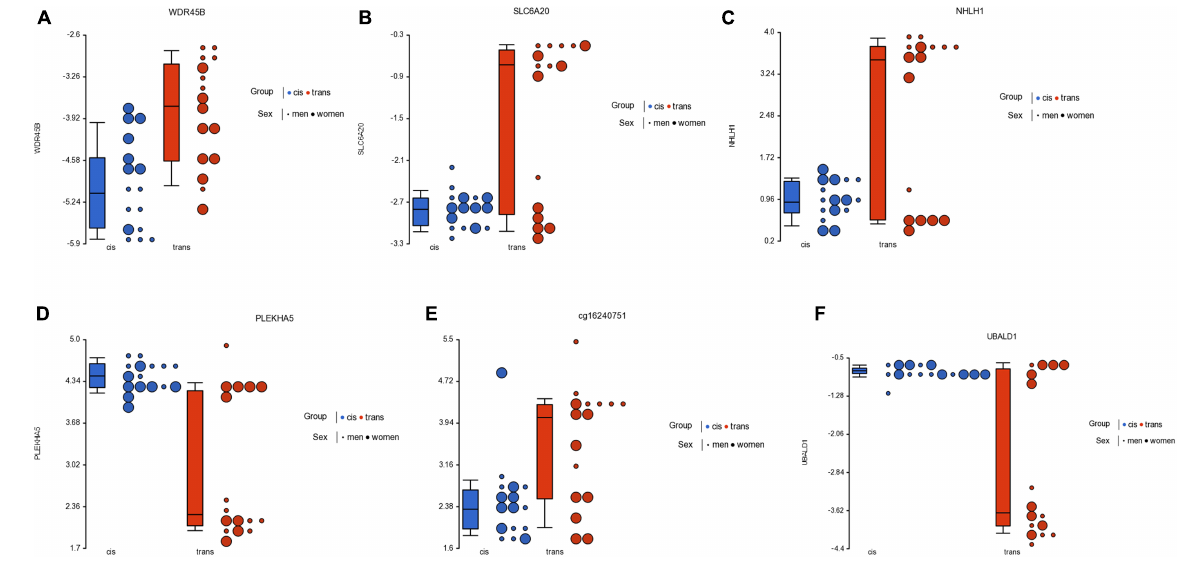
could be involved in brain development, and that epigenetic factors play a role in a differential development that might be related to GI.